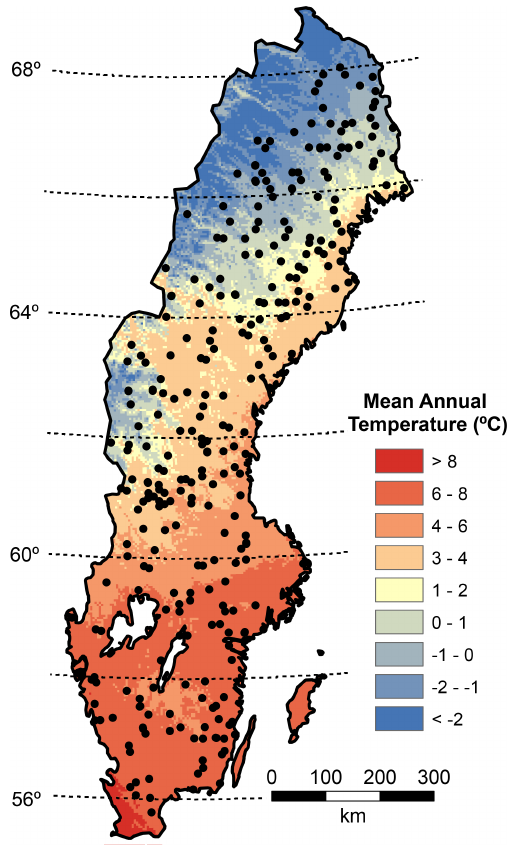
Figure 1. Map depicting mean annual temperature (MAT), latitude, and the plot locations (black